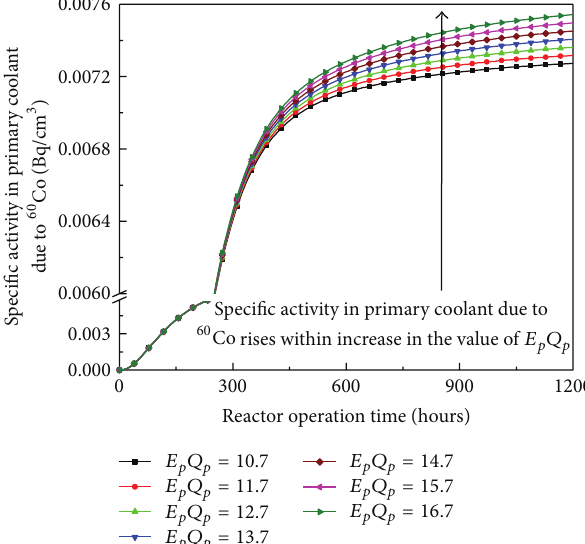
Figure 13: Specific activity of 60 Co in primary coolant of PWR with different values of 𝐸 𝑃 𝑄 𝑃